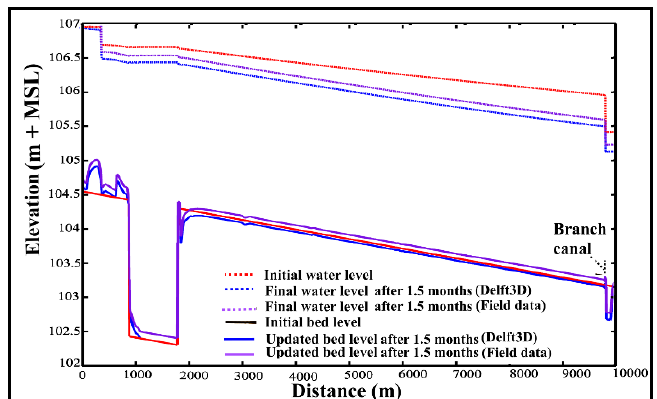
Figure 3. Bed level and water level in the main canal including the settling basin.